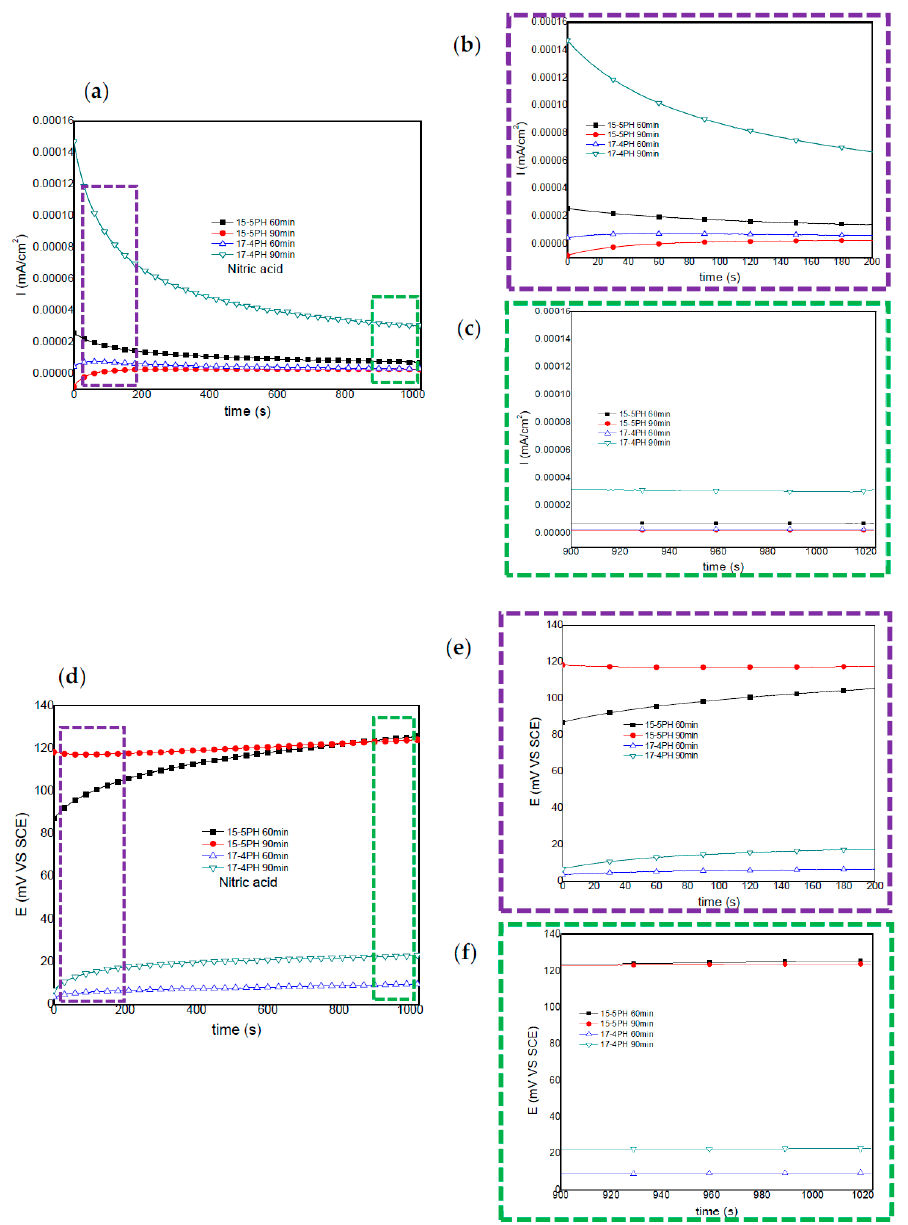
Figure 4. Electrochemical current and potential noise-time series for 15-5PH and 17-4PH samples passivated in nitric acid at 49 °C, exposed in a 5 wt. % NaCl solution ( a , d ). Windowing of ECN from 0–200 and 900–1024 s ( b,c ); windowing of EPN from 0–200 and 900–1024 s ( e , f ).